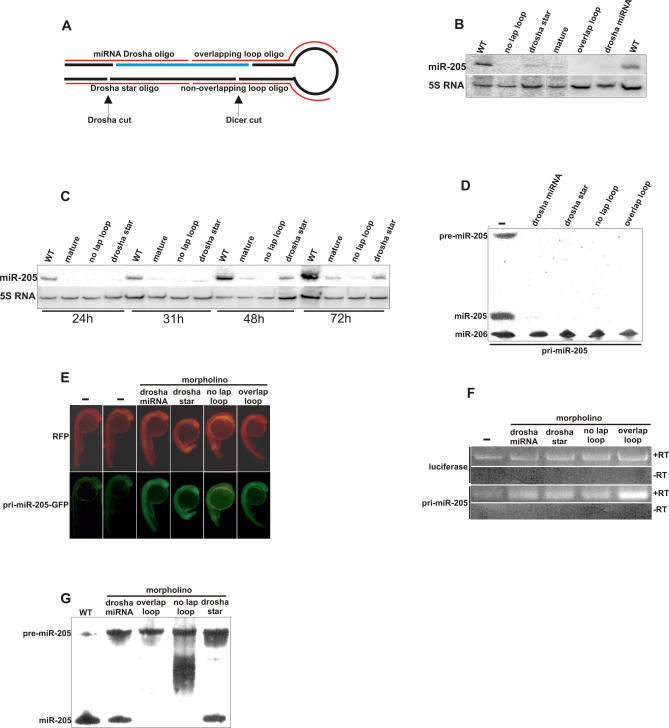
Morpholinos Targeting the Precursor miRNA Interfere with miRNA Maturation(A) Design of morpholinos targeting the precursor miRNA.(B) Northern blot analysis of miR-205 in 30-h-old embryos injected with different morpholinos against pri-miR-205. 5S RNA serves as a loading control.(C) Time series of miR-205 expression after injection of mature, no lap loop, and drosha star morpholinos against pri-miR-205.(D) Northern blot analysis of miR-205 derived from embryos injected with a GFP-pri-miR-205 transcript and four different morpholinos targeting pri-miR-205. Co-injected miR-206 serves as an injection and loading control. Embryos were collected 8 h after injection.(E) GFP expression in 24-h embryos injected with morpholinos and a GFP-pri-miR-205 construct as used in (C). Pri-miR-205 is positioned just upstream of the polyA signal in the 3′ UTR of the GFP mRNA. Red fluorescent protein (RFP) serves as an injection control.(F) RT-PCR analysis of injected GFP-pri-miR-205 mRNA with (+) and without (−) co-injected morpholinos. Luciferase serves a an injection control. Embryos were collected 8 h after injection.(G) Northern analysis of the effect of morpholinos on an injected miR-205 precursor. Embryos were collected 8 h after injection.WT, wild type.